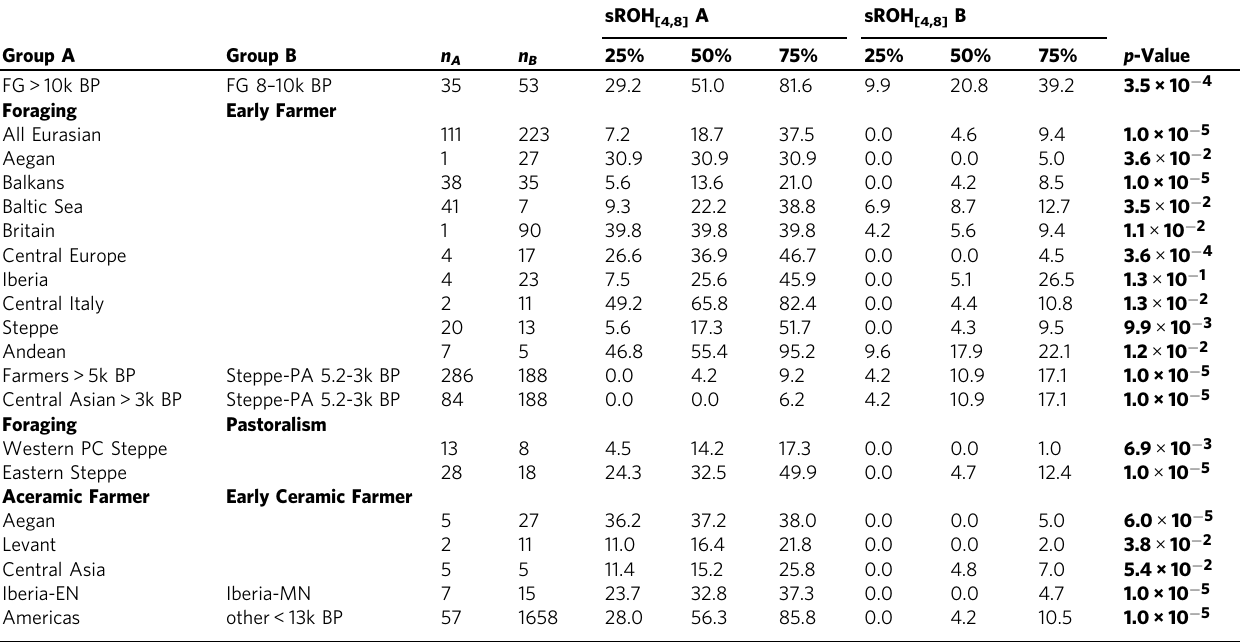
Table 1 Comparison of statistics for sROH [4,8] for pairs of